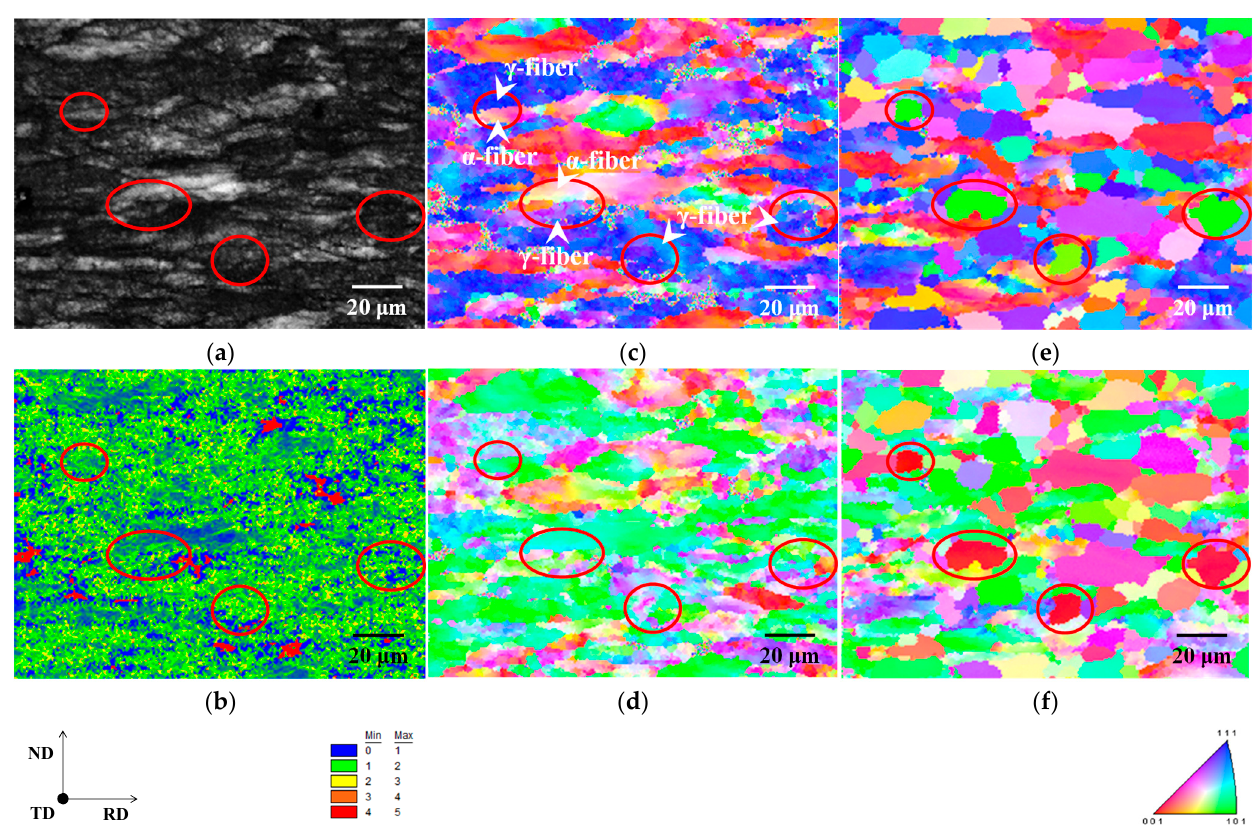
Figure 7. ( a ) Image quality, ( b ) kernel average misorientation, and inverse pole figure maps in the ( c ) normal and ( d ) rolling directions of cold-rolled specimen A and inverse pole figure maps in the ( e ) normal and ( f ) rolling directions of annealed specimen A.